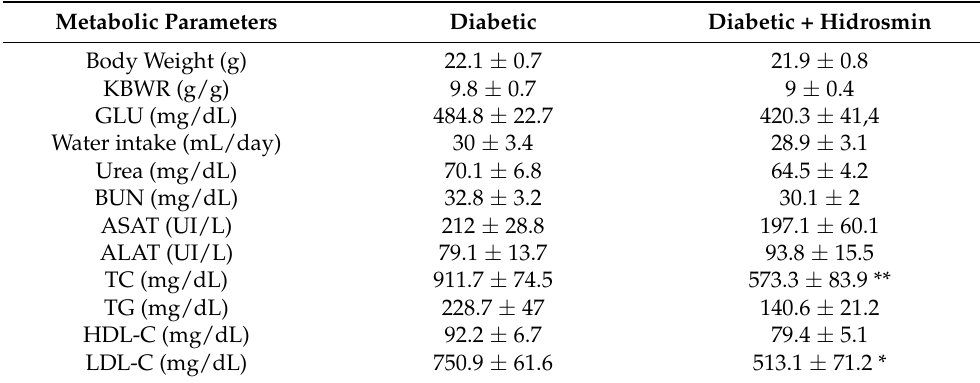
HDL-C (mg/dL) LDL-C (mg/dL) 750.9 ± 61.6 513.1 ± 71.2